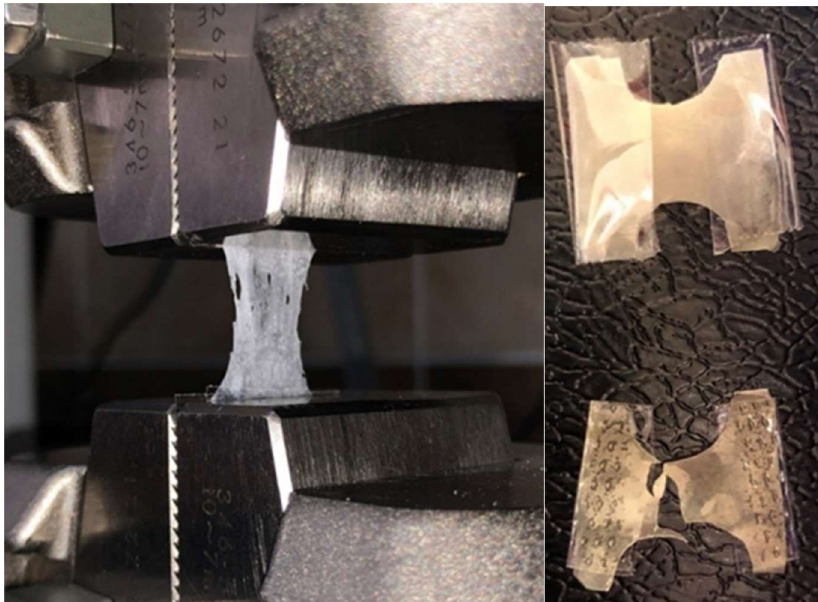
Figure 4. Elongation percentage experiment and images taken during the experiment.